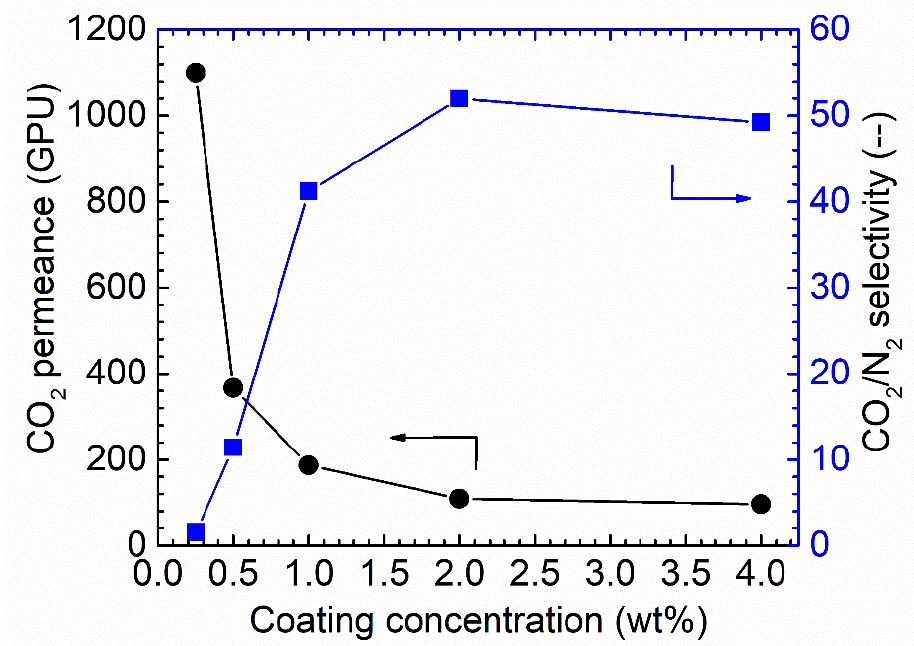
Figure 7. CO 2 separation performances under the humid conditions for the Pebax/PAN membrane- coated via various coating concentrations, 100% RH, feed pressure of 2 bar at 35 °C.